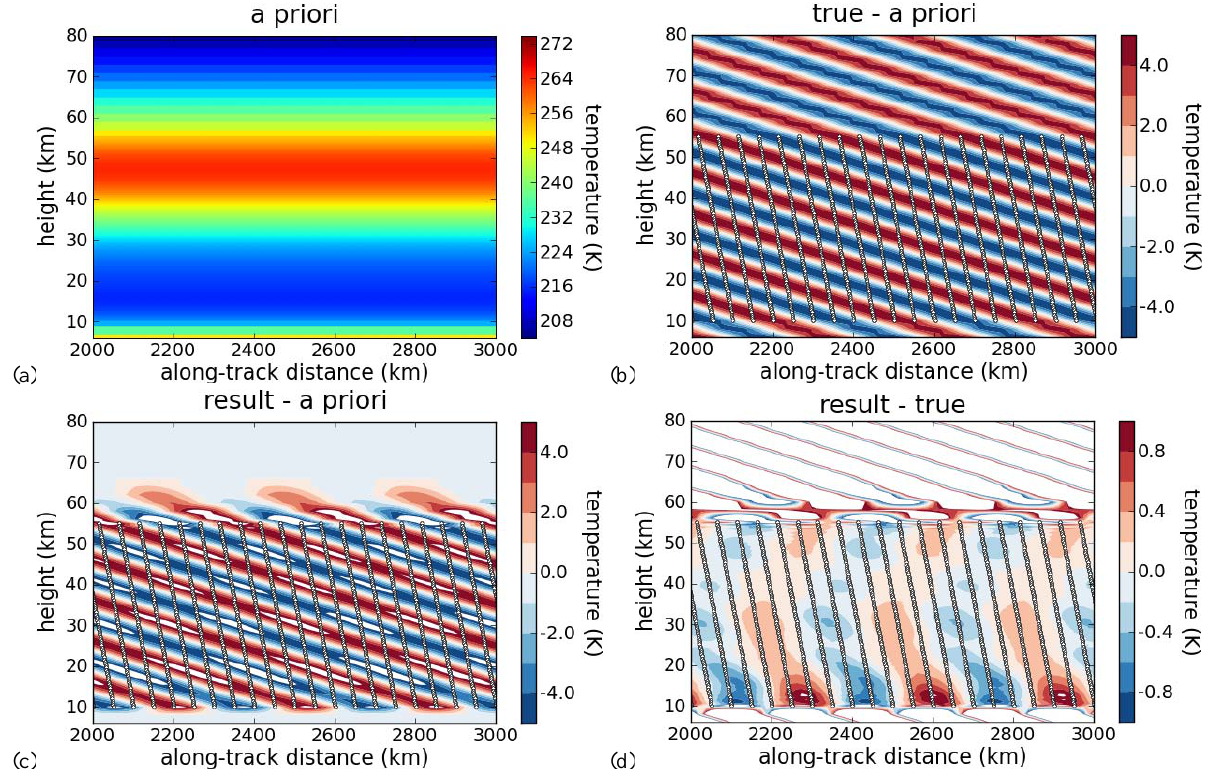
Fig. 5. Example of a retrieval end-to-end test used for generating the observational filter. The instrument flies from right to left and measures radiance coming from the right. A wave perturbation with 10km vertical wavelength and 320km horizontal wavelength tilted towards the instrument is super-imposed onto the a priori atmosphere depicted in (a) . The difference between the disturbed atmosphere and the a priori is shown in (b) . The difference between the retrieval result and the a priori – that is the retrieved wave perturbation – is depicted in (c) and the difference between the result of the retrieval and the true state is depicted in (d) . The tangent points of the satellite measurements are shown as white circles. Please note that the horizontal retrieval grid is four times finer than the measurement grid. For better representation of the investigated structure only kilometres 2000 to 3000 of the simulated 6000kilometres are